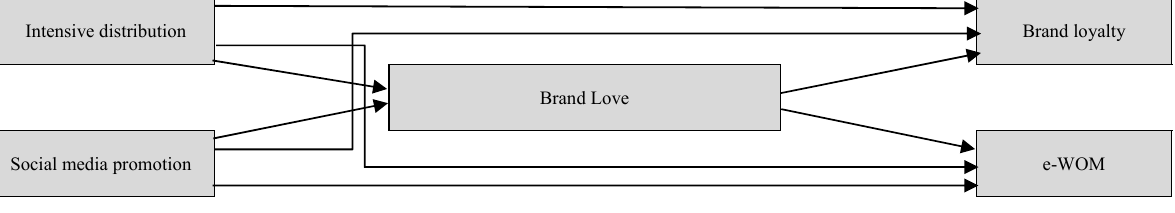
Fig. 1. Research Concept